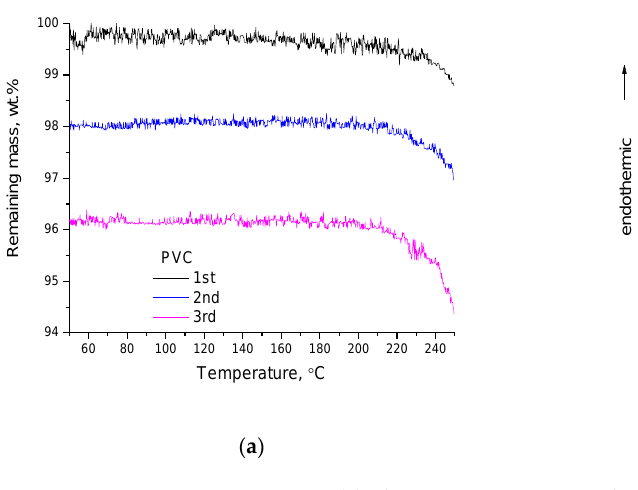
Figure 8. ( a ) Three consecutive TGA heating cycles of PVC up to 250 °C. The green line points out a decreasing trend of mass in the range 125–200 °C in the first heating; ( b ) Three consecutive DSC scans of PVC up to 180 °C and a preliminary first scan up to 250 °C. The dashed line has been drawn to enable the recognition of the peaks.